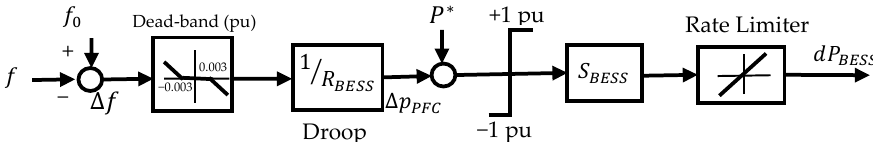
Figure 3. Block diagram of the implementation primary frequency control (PFC) using a battery energy storage system (BESS).